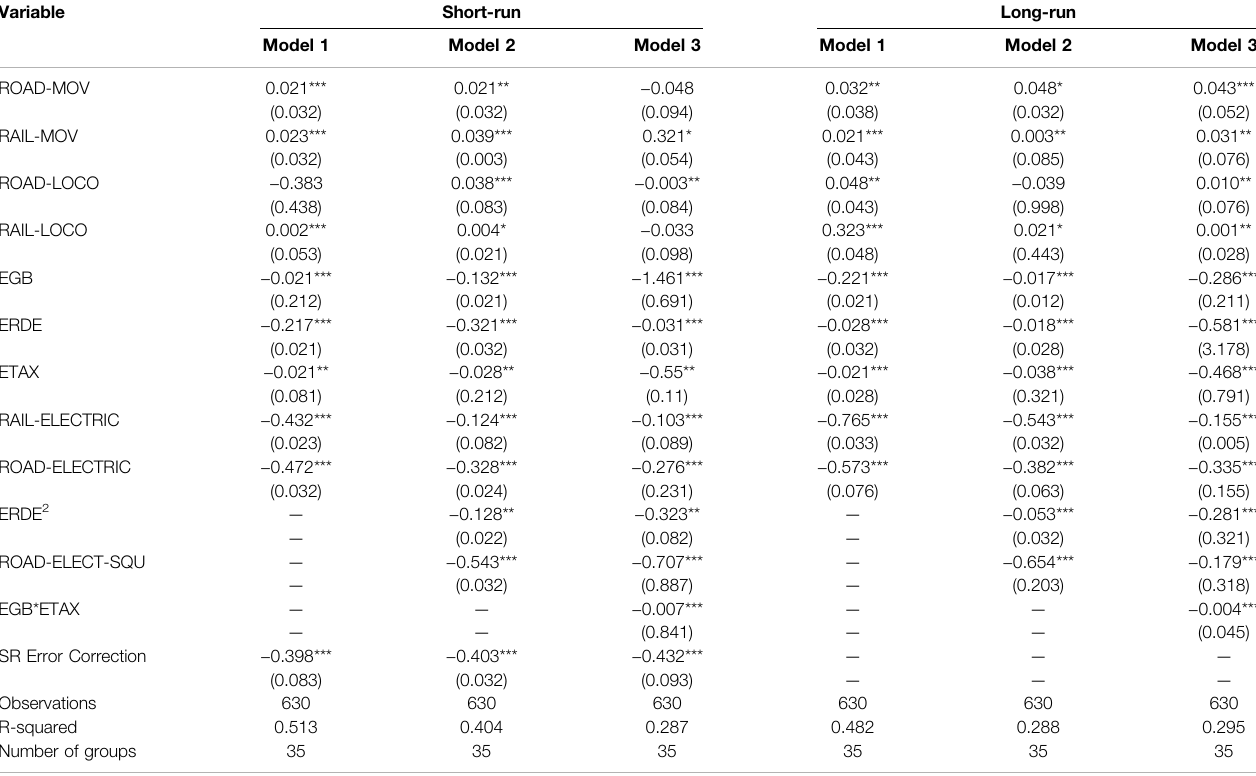
TABLE 7 | The role of environmental expenditures and green transport.